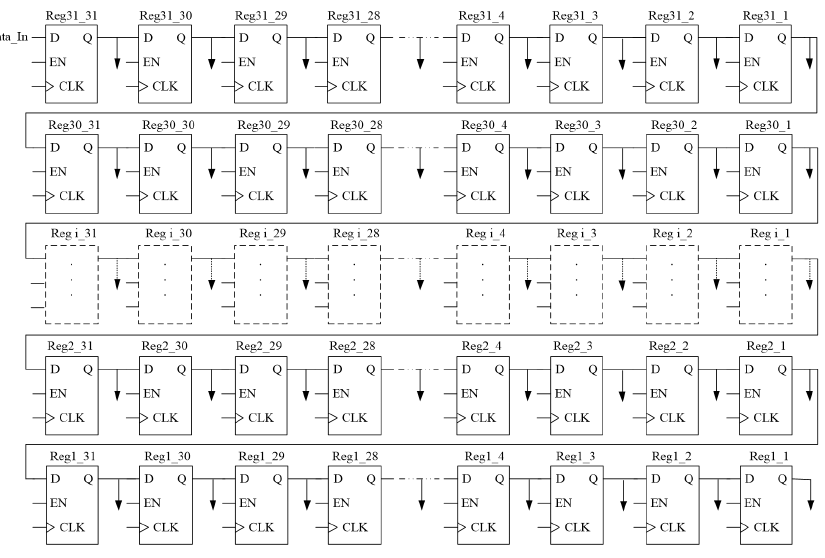
Figure 12. Serial shift register groups of the reference sub-area.